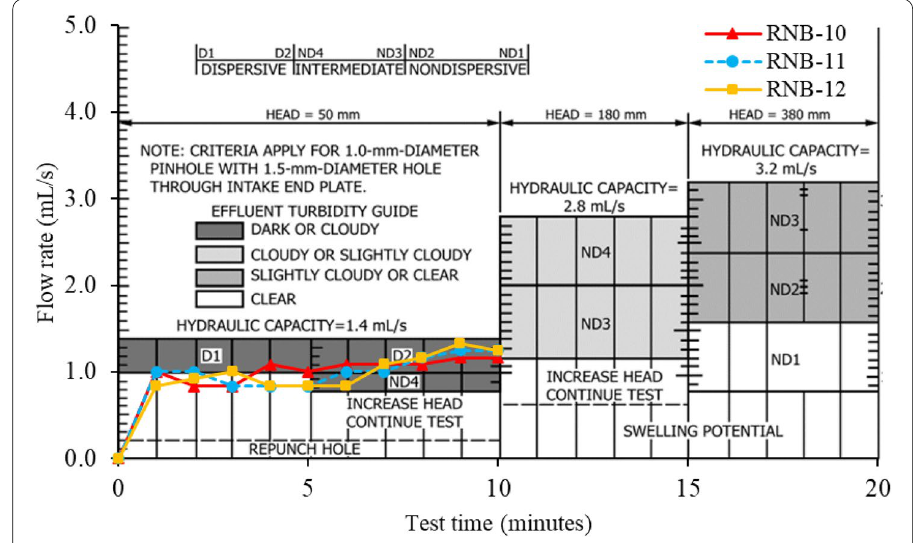
Fig. 13 Flow rate and dispersive grade of SP‑SM soils